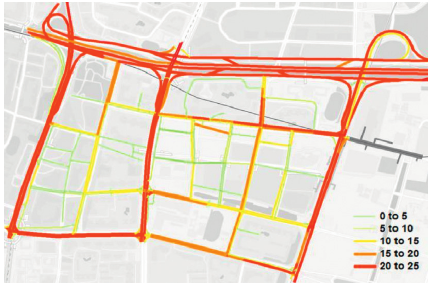
Figure 2: Spatial coverage of floating vehicle data within 2h.